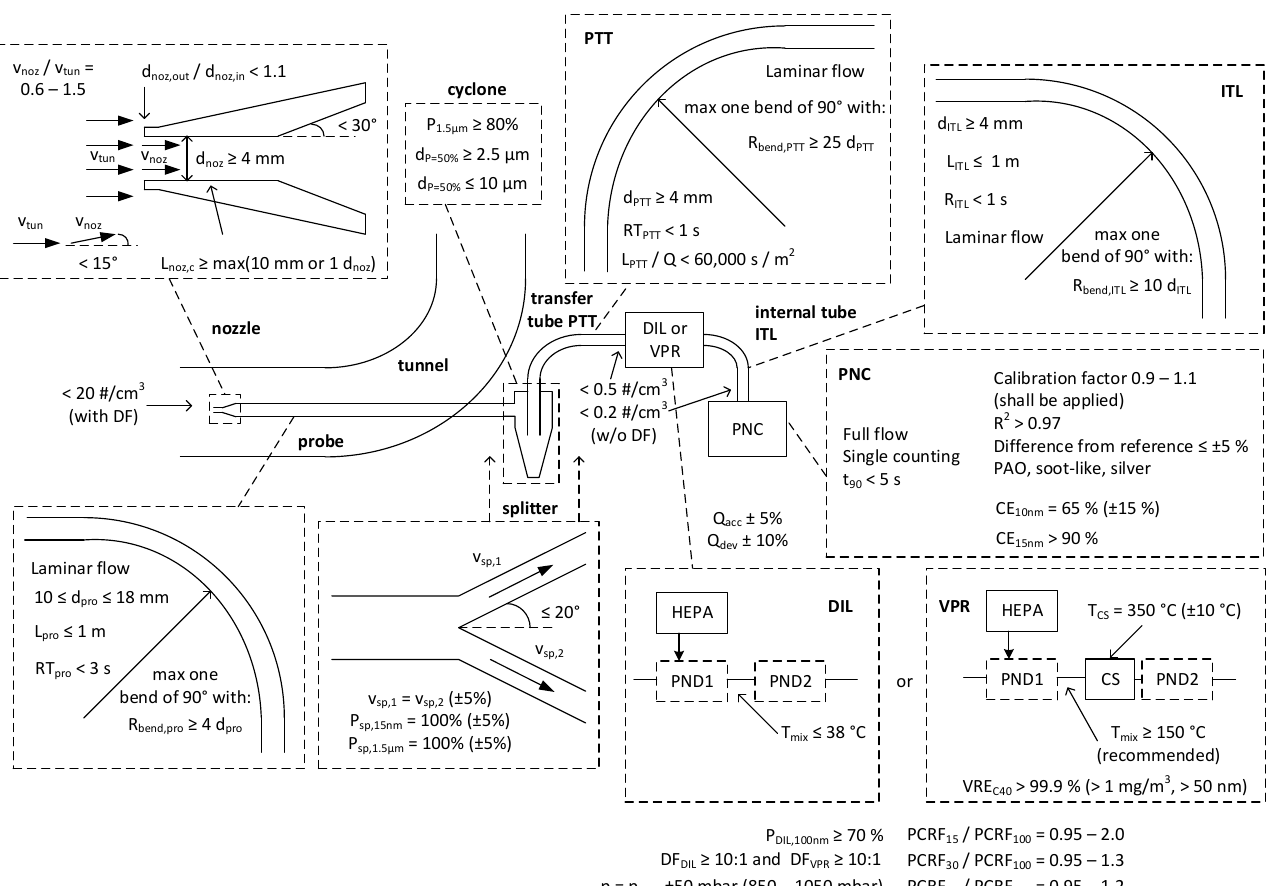
Figure 2. Overview of the technical requirements of the particle number (PN) setup. acc = accuracy; CE = counting efficiency; d = diameter; dev = deviation; DF = dilution factor; DIL = diluter; HEPA = high-efficiency particle air filter; L = length; noz = nozzle; P = penetration; p = pressure; PAO = polyalphaolefin; PCRF = particle concentration reduction factor; PNC = particle number counter; PND = particle number diluter; Q = flow; tun = tunnel; R = radius; RT = residence time; sp = splitter; V = velocity; VRE = volatile removal efficiency; VPR = volatile particle remover.